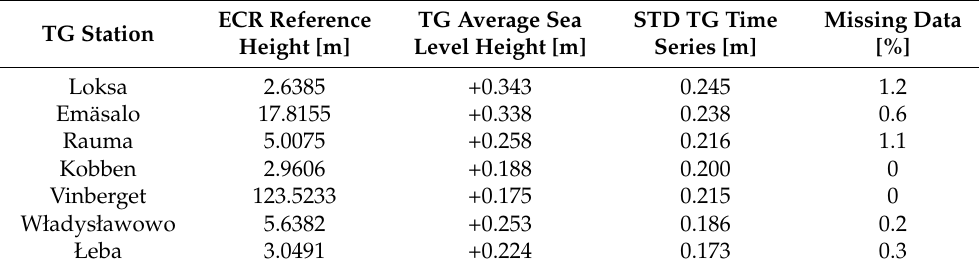
Table 7. Summary of the TG and ECR levelling results for year 2020, referred to the national realizations of the EVRS vertical